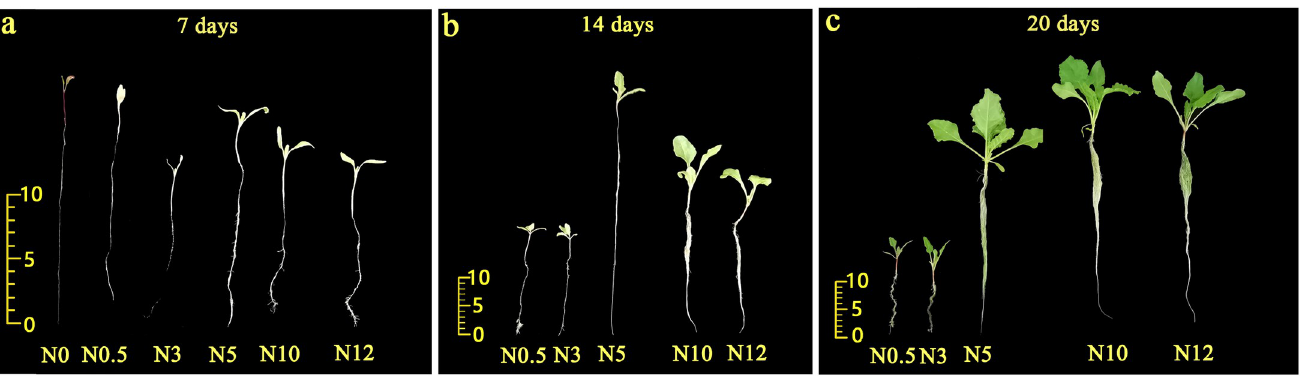
Fig 1. Morphological changes of sugar beet seedlings under different nitrogen